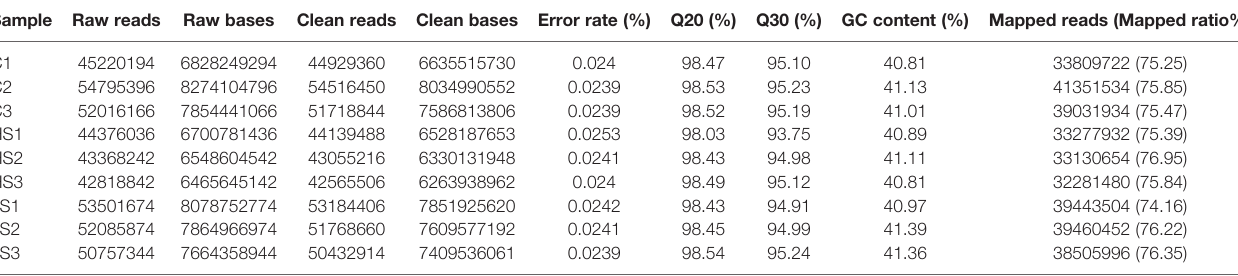
TABLE 2 | Statistics for transcriptome sequencing data from the Pinctada maxima gill.